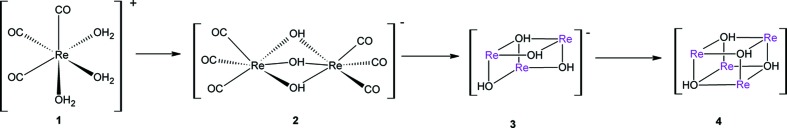
Formation of the dinuclear, trinuclear and tetranuclear rhenium clusters from fac-[Re(CO)3(H2O)3]+. Note Re, as indicated in complexes 3 and 4 represents the [Re(CO)3] fragment. Illustrated without the carbonyl ligands for the sake of clarity.